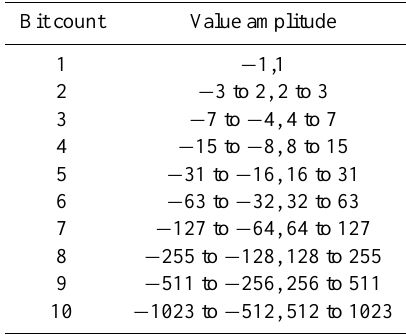
Table A1. Bit streaming: entropy